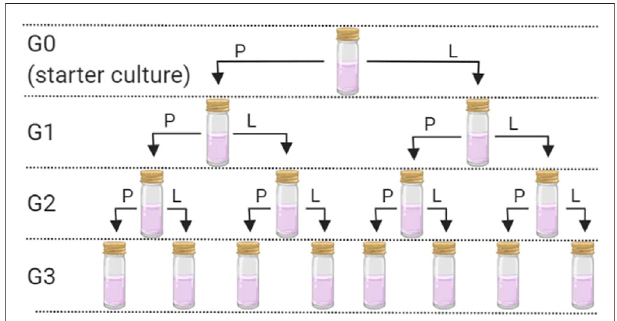
FIGURE 1 | Generation overview and sampling scheme. P = use of the pellicle for the inoculum and L = use of the liquid phase for the inoculum. This process was followed for each of the two starter cultures. Following G0, each inoculation was carried out in